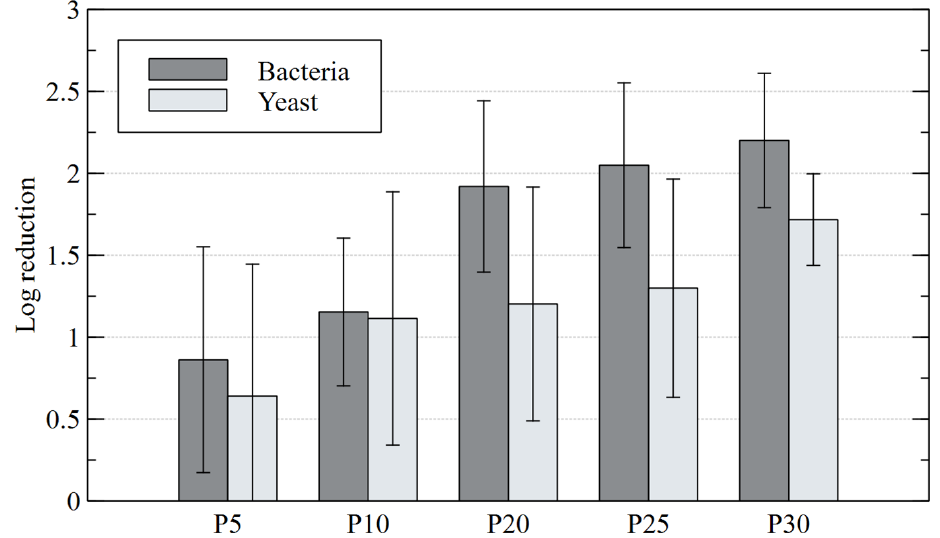
Figure 5. Logarithmic CFU reduction of microorganisms colonizing diatomaceous earth for different plasma treatment times.